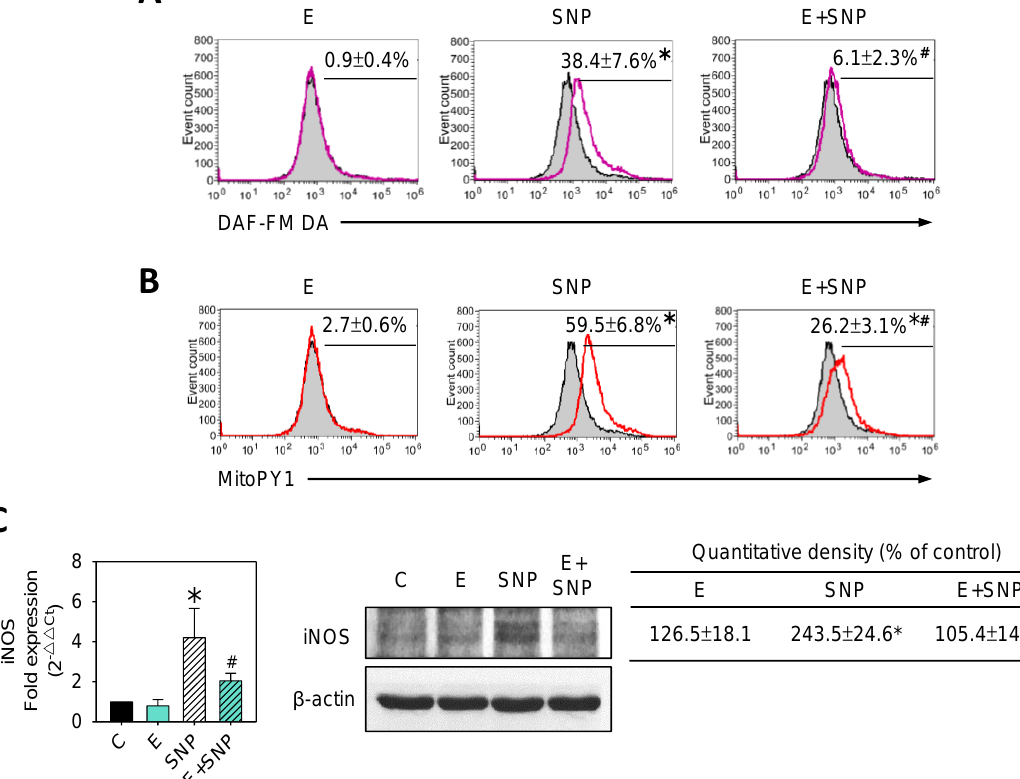
Figure 6. The effect of SNP and/or S-Equol on nitric oxide (NO) and hydrogen peroxide (H 2 O 2 ) production of primary chondrocytes. After cells were treated with S-Equol for 24 h in the presence or absence of SNP for another 24 h, ( A ) NO or ( B ) H 2 O 2 production was determined by DAF-FM DA or MitoPY1 staining, respectively, followed by flow cytometry. The gray filled area is the untreated control, and those delimited by the purple or red lines are the treated groups. ( C ) iNOS mRNA (left side) and protein (right side) levels were measured by real-time PCR and Western blotting. β-actin was used as the internal control. The data are expressed as fold changes compared to that in untreated control. The results are expressed as the mean ± S.D. for three separate experiments. * p < 0.05 compared to the untreated control. # p < 0.05 compared to the corresponding SNP treated group.